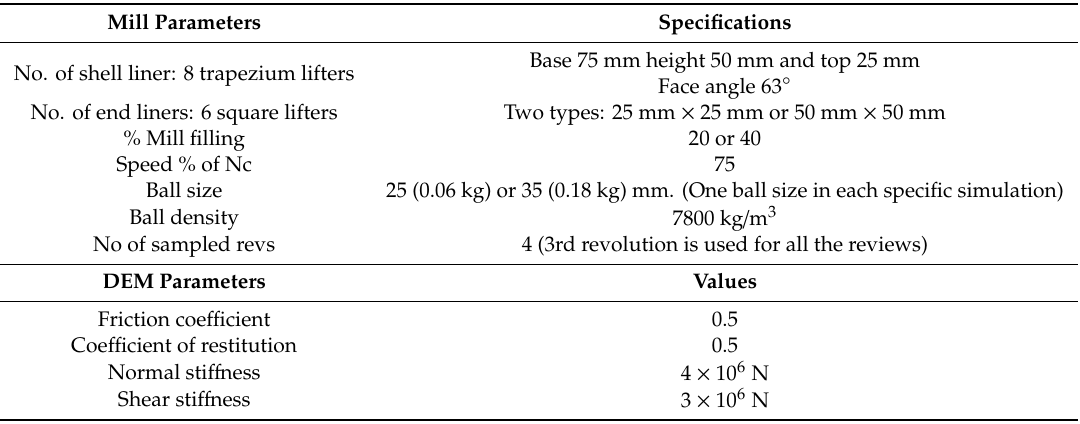
Table 1. Simulation